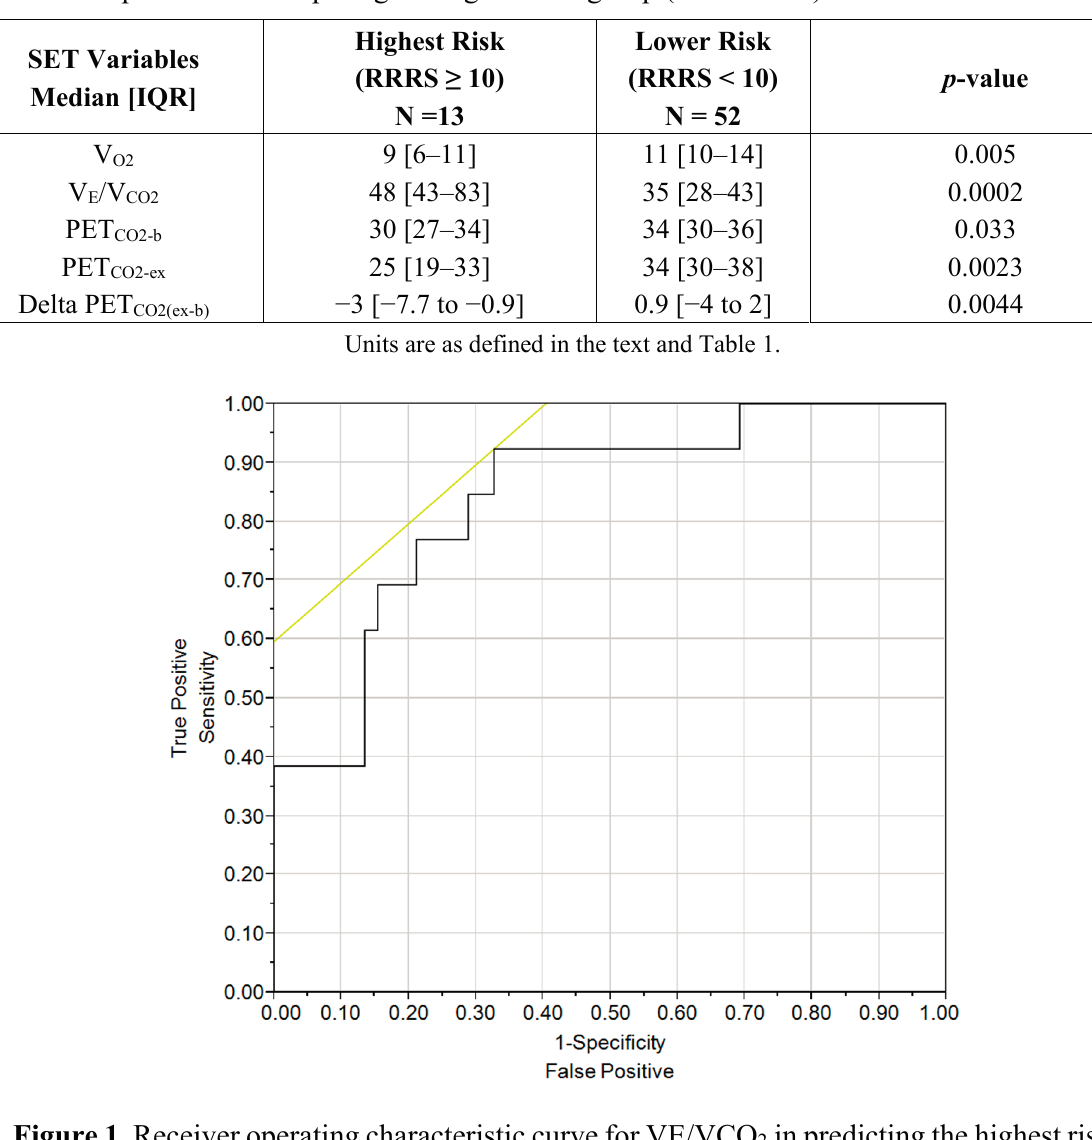
Figure 1. Receiver operating characteristic curve for VE/VCO 2 in predicting the highest risk category (RRRS ≥ 10). The AUC was